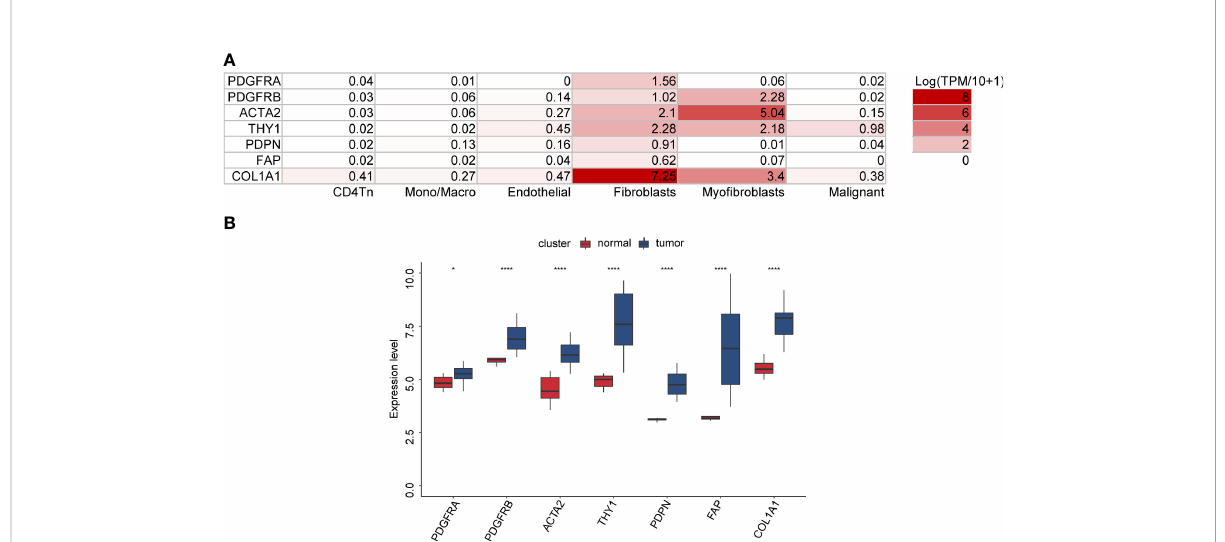
FIGURE 1 The expression of seven CAF markers in OV. (A) The distribution of seven CAF markers in OV cell subpopulations through the TISCH database (OV_GSE118828 dataset). (B) Seven CAF markers were upregulated in ovarian cancer stroma compared with normal ovarian stroma (GSE40595 dataset).